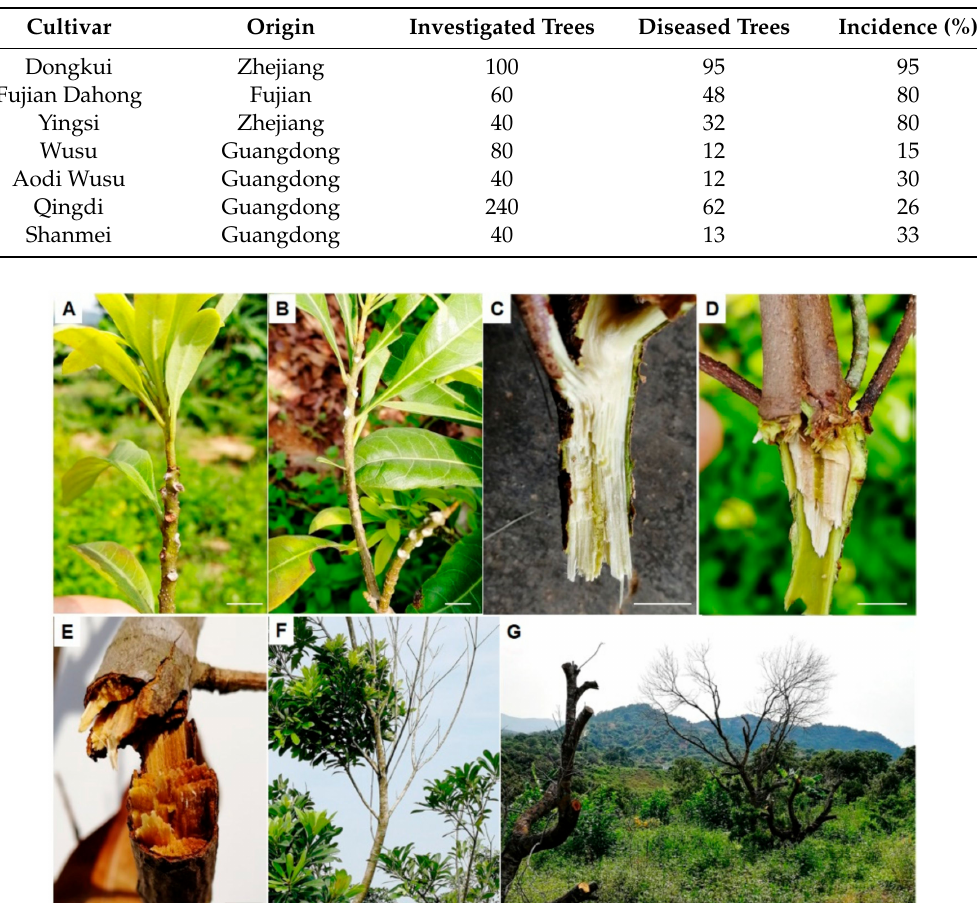
Figure 1. Symptoms of bayberry twig blight disease in Jinzao town. ( A ) and ( B ), white mycelia on petiole bases in young shoots; ( C ), healthy twig with light green interior; ( D ), newly diseased twigs with interior turning brown; ( E ), late-onset twig completely turning brown and dry; ( F ), defoliation of the infected trees; ( G ), bald shoots and trunks. Bar = 1